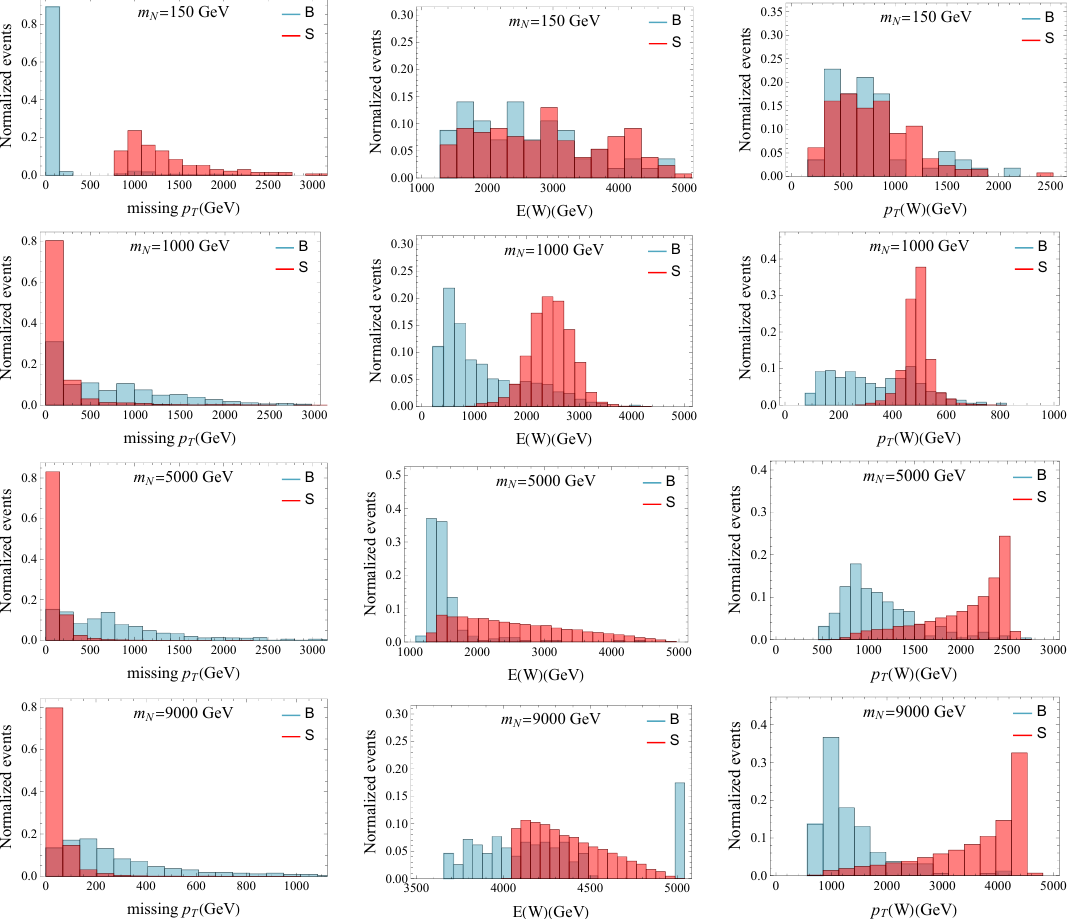
Figure 5 . The normalized signal and background distributions of µ -flavored HNL at 10 TeV. The left column refers to the missing p T distribution after pre-selection and central W cut. The middle column refers to E ( W ) distribution after missing p T cuts. The right column refers to p T ( W ) distribution after E ( W ) cut. Blue and red bins represent background and signal distributions, respectively.